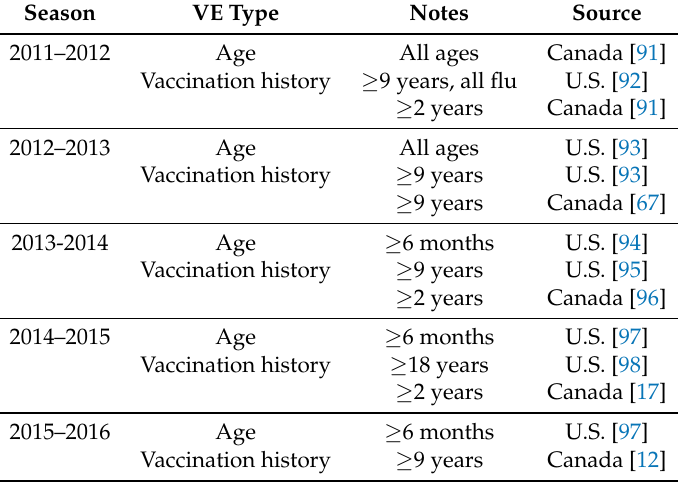
Table A1. Sources of data for Figure 1. Except where noted below, vaccine effectiveness is shown only for the dominant circulating subtype each